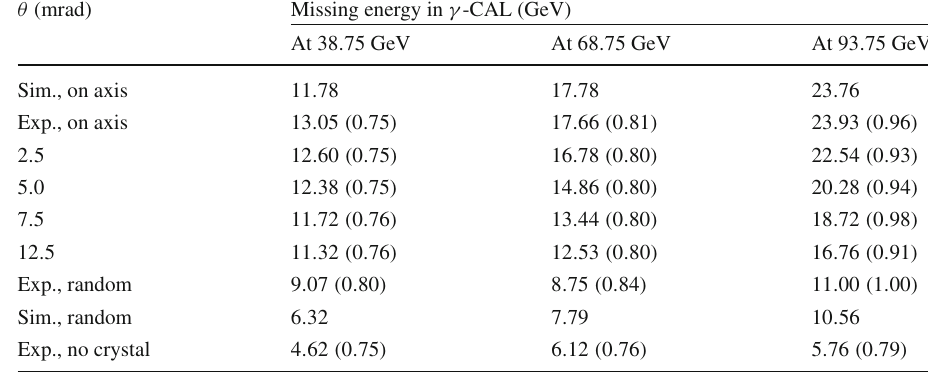
θ (mrad) Missing energy in γ -CAL (GeV)